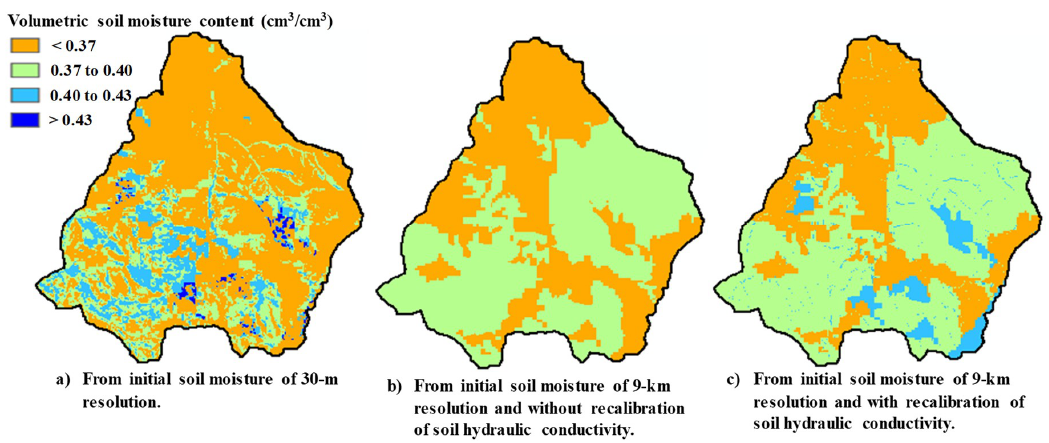
Figure 14. Simulated soil moisture state at the peak of the hydrograph. ( a ) from initial soil moisture of 30-m resolution; ( b ) from initial soil moisture of 9-km resolution and without recalibration of soil hydraulic conductivity; ( c ) from initial soil moisture of 9-km resolution and with recalibration of soil hydraulic conductivity.